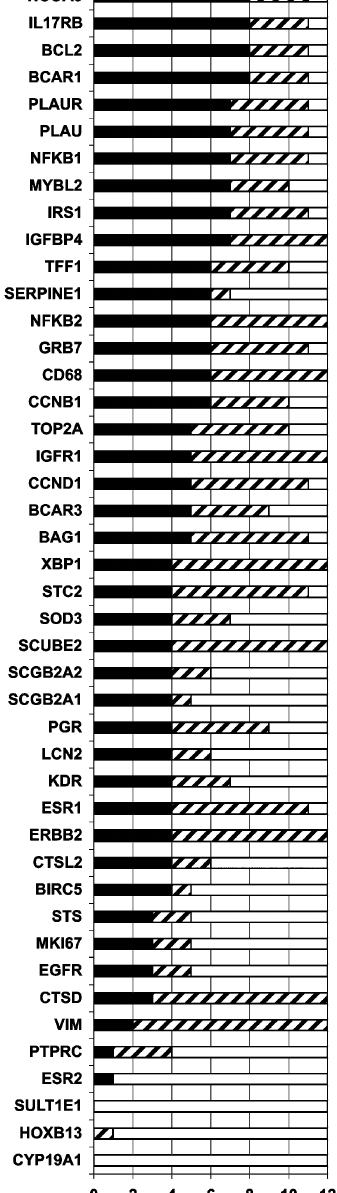
Fig. 1. Analysis of intratumoral heterogeneity by statistical compar- ison of individual gene expression levels in matched pairs of FNA samples from 12 breast cancers. For each gene ( y -axis) and the num- ber of patients ( x -axis), the distribution of genes showing either no significant difference in gene expression ( p > 0 . 05, indepen- dent t -test, black column), or a significant difference in expression ( p < 0 . 05, hatched column) between the tumor halves are shown. Some gene pairs within an individual could not be statistically eval- uated as the gene expression in at least one sample was under the detectable limit (white